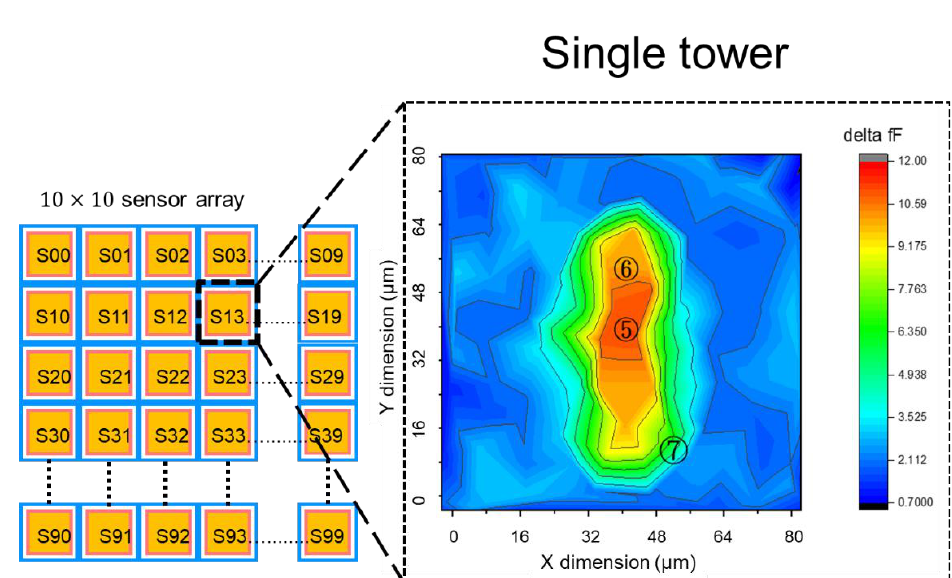
Figure 7. Capacitance change contour plot for single tower in a pixel. The contour plot represents the capacitance change absorbed by ion-binding. The area noted in ⑤ _RED is most sensitivity zone (hot zone), and noted in ⑥ _YELLOW is the second sensitivity zone and ⑦ is thirdly. The simulation is performed by HFSS. The capacitance change area ⑤ _RED, ⑥ _YELLOW, ⑦ _GREEN account for 36% of a pixel.